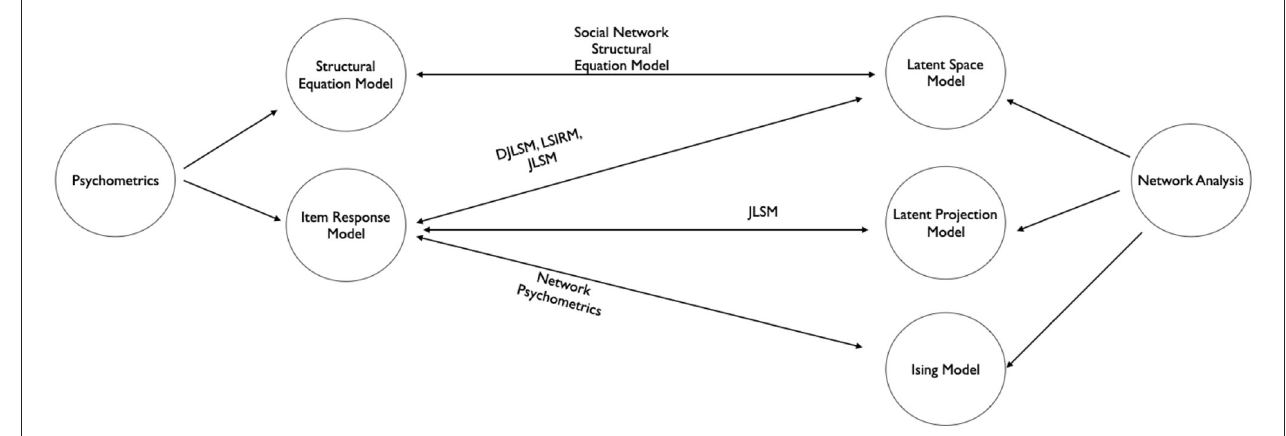
FIGURE 1 | Diagram summarizing the relationship between psychometric models and network models 1 . Double-headed arrows indicate integrations of two frameworks with the resulting framework at the center. 1 JLSM: A earlier version of JLSM contains the vector product latent effect (Wang,